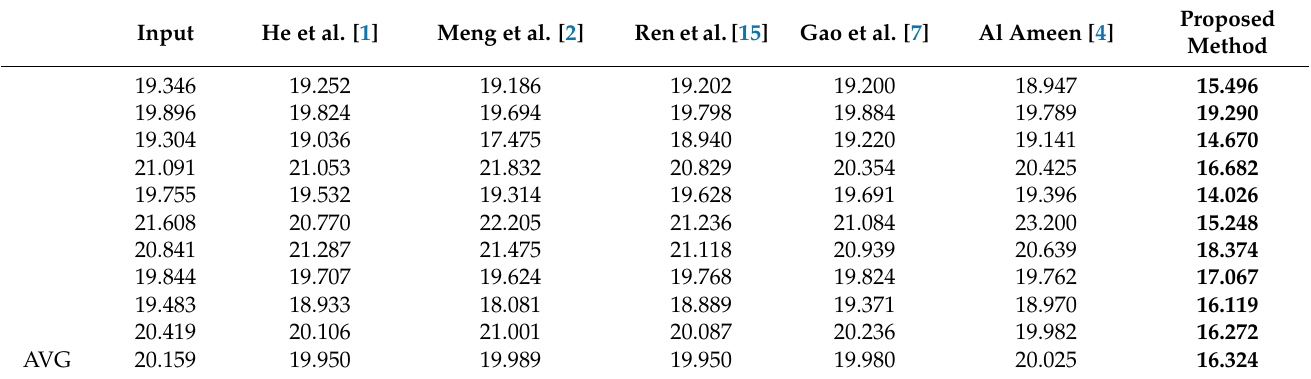
Table 1. The comparison of the NIQE [33] scores from Figure 6 (If the score is low, the image is well enhanced. The lowest are indicated in bold ).